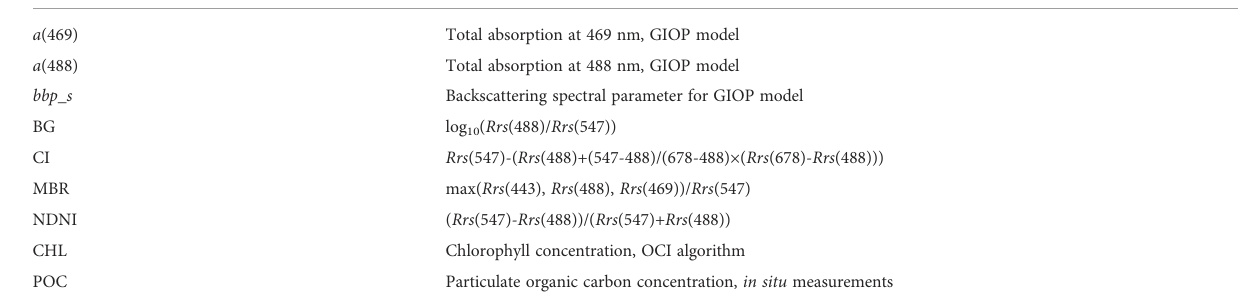
TABLE 2 The de fi nitions of indices used for PON retrieval models.